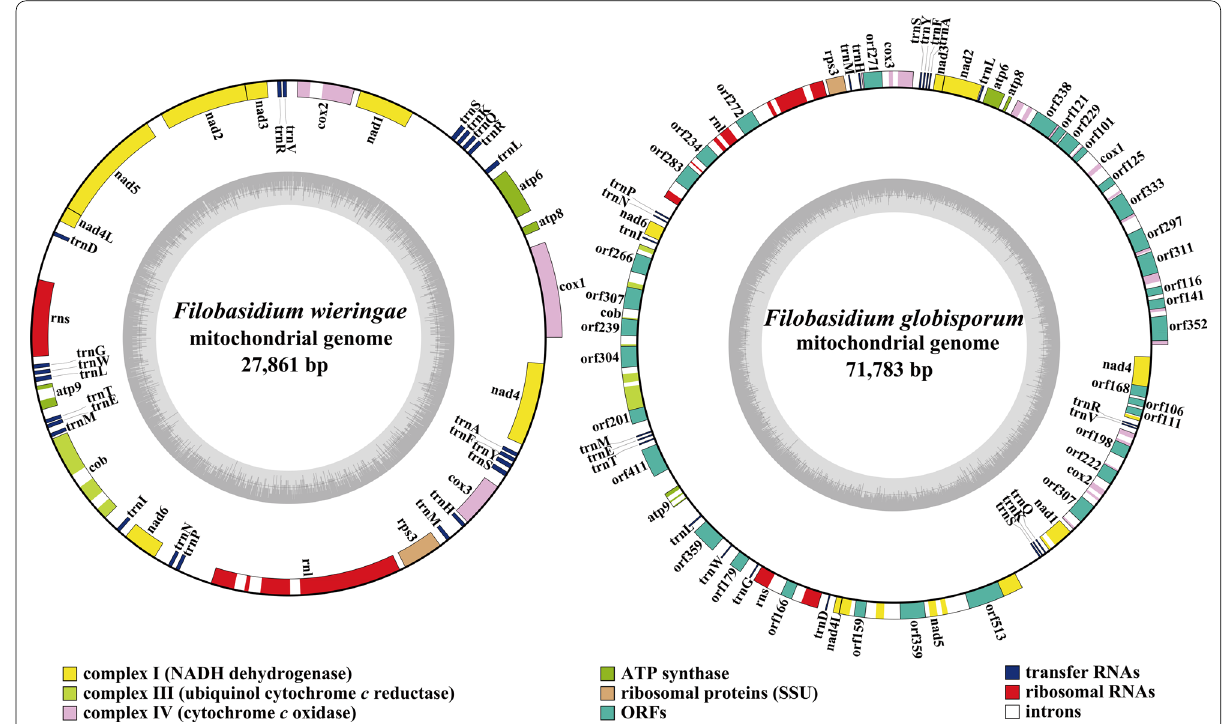
Fig. 1 Circular maps of the mitochondrial genomes of two Filobasidium species. Genes are represented by different colored blocks. Colored blocks outside each ring indicate that the genes are on the direct strand, while colored blocks within the ring indicates that the genes are located on the reverse strand. The inner grayscale bar graph shows the GC content of the mitochondrial sequences. The circle inside the GC content graph marks the 50%